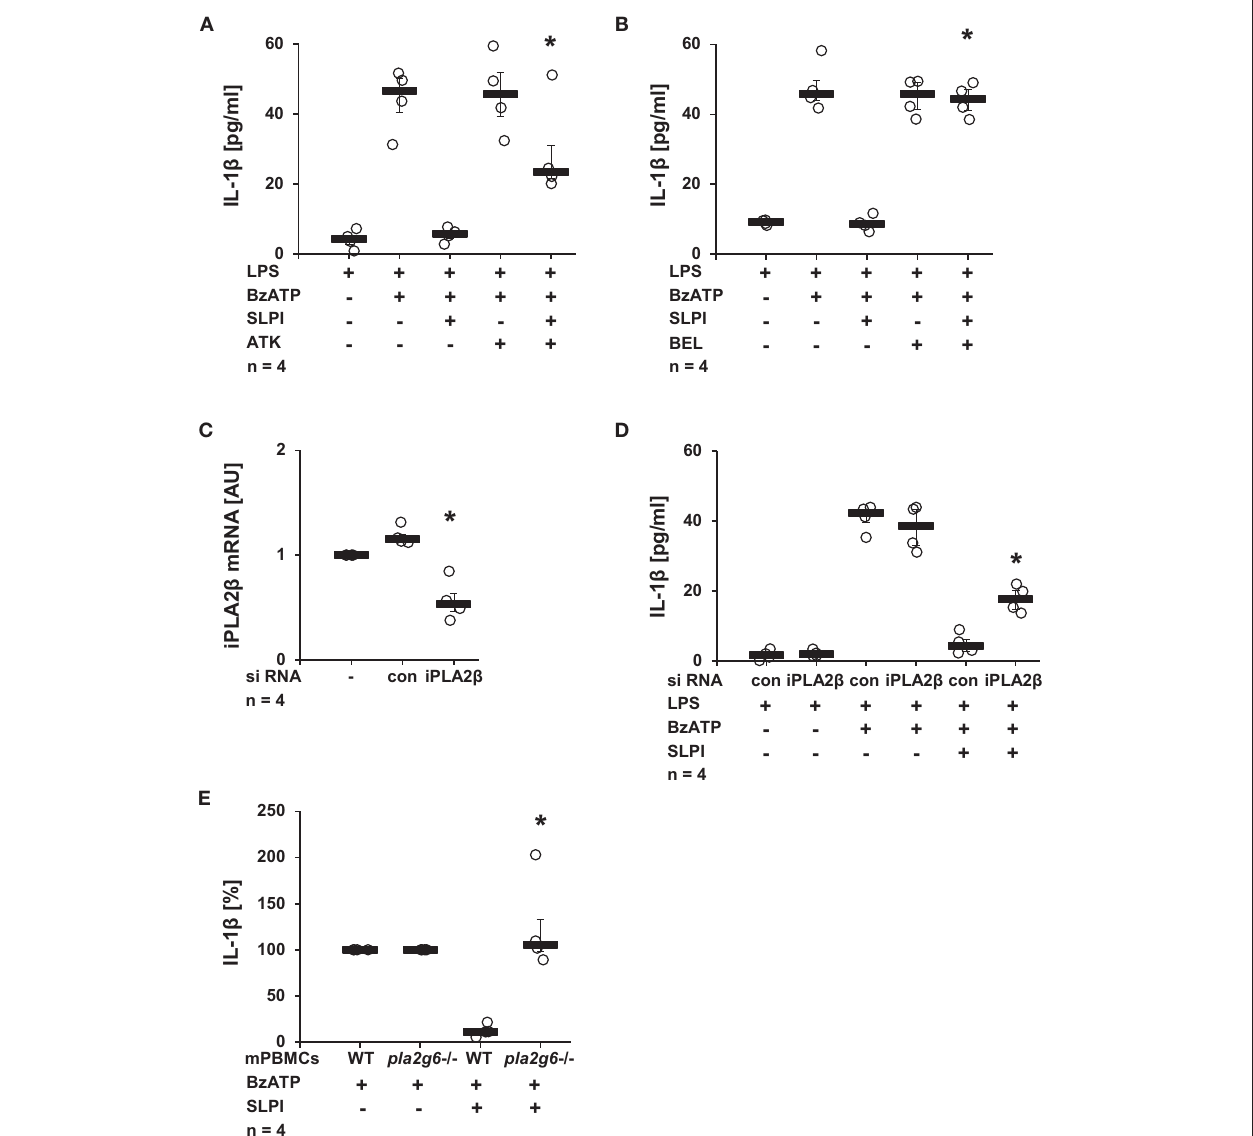
FIGURE 10 | SLPI activates calcium-independent phospholipase A2 β (iPLA2 β ). Human monocytic U937 cells were primed with LPS (1 µ g/ml) for 5h and further stimulated with 2 ′ (3 ′ )-O-(4-benzoylbenzoyl)adenosine 5 ′ -triphosphate triethylammonium salt (BzATP; 100mM) for 30min. SLPI was applied in the presence of different PLA2 inhibitors. The concentration of IL-1 β in cell culture supernatants was measured by ELISA. (A) Treatment with the general PLA2 inhibitor arachidonyl trifluoromethyl ketone (ATK) or (B) application of bromoenol lactone (BEL), more specific for iPLA2 β , blunted the SLPI-mediated inhibition. (A,B) n = 4, * p ≤ 0.05 significantly different compared to cells stimulated with LPS, BzATP, and SLPI. (C,D) The expression of iPLA2 β was silenced by siRNA. (C) The mRNA level of iPLA2 β , as measured by real-time PCR, was diminished upon transfection with iPLA2 β siRNA. * p ≤ 0.05 significantly different compared to cells transfected with control siRNA (con) (D) Silencing of the iPLA2 β expression diminished the SLPI-mediated inhibitory effect on the BzATP-induced release of IL-1 β . n = 4, * p ≤ 0.05 significantly different compared to cells transfected with control siRNA (con) and stimulated with LPS, BzATP and SLPI. (E) Mouse peripheral blood mononuclear cells (mPBMCs) isolated from wild-type (WT) or Pla2g6 -gene-deficient mice were stimulated with BzATP in the presence and absence of SLPI (10 µ g/ml). The IL-1 β released to cell culture supernatants was measured by ELISA. The IL-1 β concentration in the absence of SLPI was set to 100% and values after SLPI application were calculated accordingly. * p ≤ 0.05 significantly different compared to cells from WT mice stimulated with BzATP and SLPI. Experimental groups were compared by Kruskal-Wallis test followed by Mann-Whitney rank sum test.